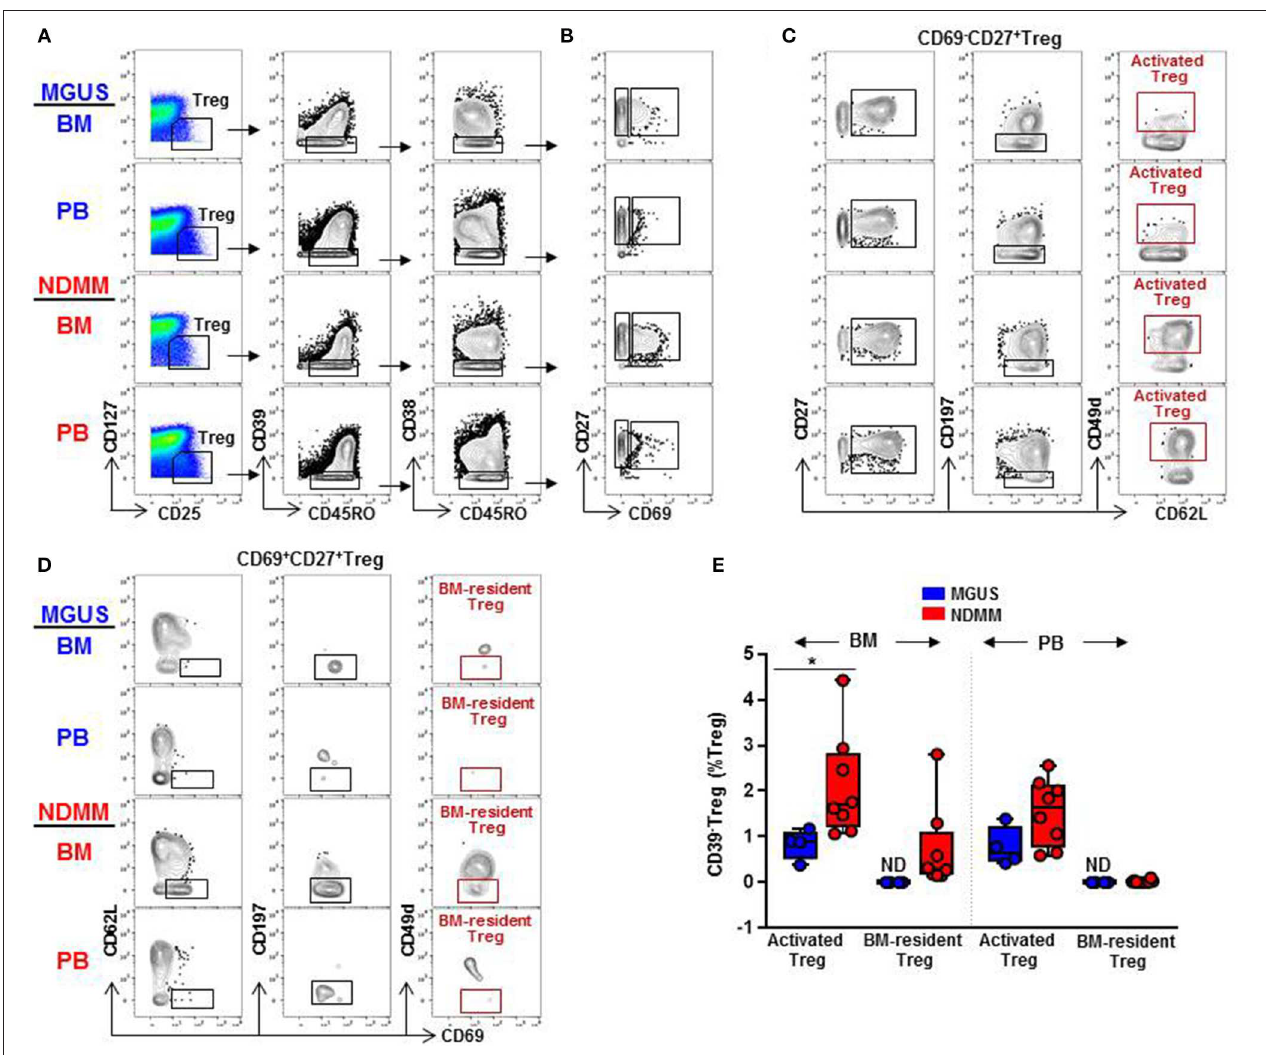
FIGURE 5 | Biaxial gating of mass cytometry data to match activated CD39 − Treg (MC15) and BM-resident CD39 − Treg (MC23) in MGUS and NDMM samples. (A) Representative biaxial gating of CD45RO + CD39 − CD38 − Treg displayed in a plot of CD27 vs. CD69 in (B) . Representative gating strategy to match (C) activated CD39 − Treg (MC15) within CD69 − CD27 + Treg and (D) BM-resident CD39 − Treg (MC23) within CD69 + CD27 + Treg. (E) Frequency of activated CD39 − Treg and BM-resident CD39 − Treg in matched BM and PB samples of MGUS ( n = 4) and NDMM ( n = 8) patients. * p < 0.05. ND, not